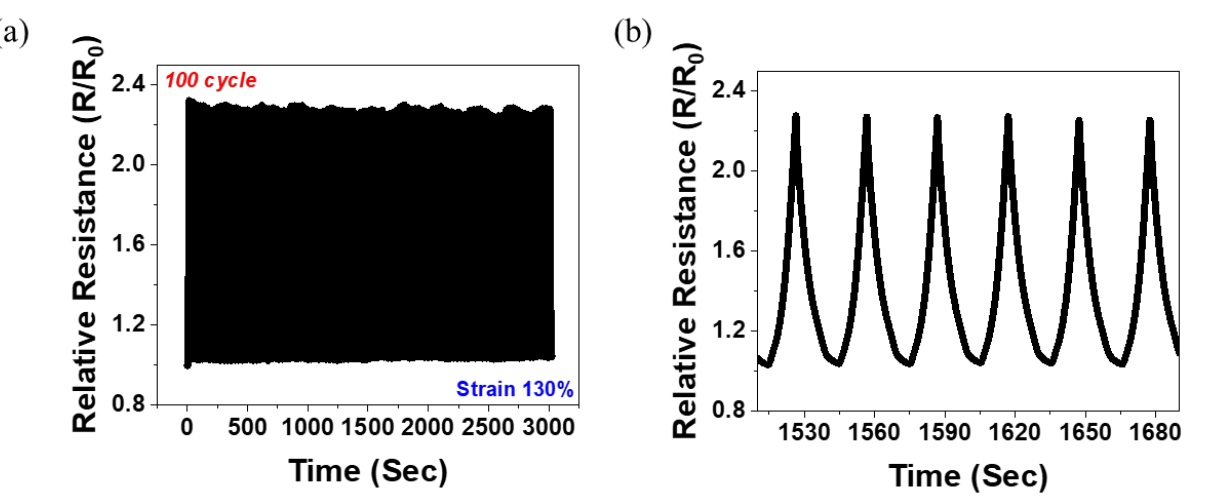
Figure 6. Dynamic strain-sensing curve for ( a ) 1 wt.% single composite strain at 150% and ( b ) 1 wt.% hybrid composite strain at 150% under 5 cycles.